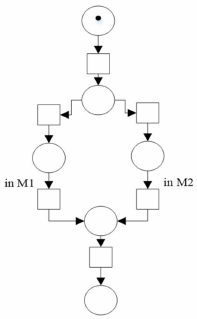
Figure 16. A petri net representing a manufacturing system with a job and 2 machine (M1 and M2) such that the job can be processed by either M1 or